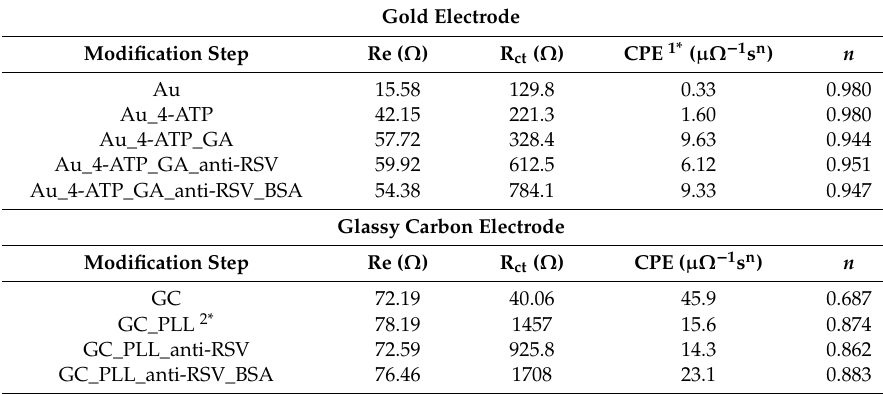
Figure 3. Measurements of biosensor fabrication steps: ( A ) cyclic voltammograms for the bare and modified Au electrode, ( B ) electrochemical impedance spectra for the bare and modified Au electrode, ( C ) cyclic voltammograms for the bare and modified GC electrode, ( D ) electrochemical impedance spectra for bare and modified GC electrode. Registered in 5 mM K 3 [Fe(CN) 6 ]/K 4 [Fe(CN) 6 ]/0.01 M PBS. Insets represent electric equivalent circuit (EEQC) utilized for fitting and data analysis. Table 1. List of values of elements calculated from the equivalent electric circuit (EEQC) for bare and modified